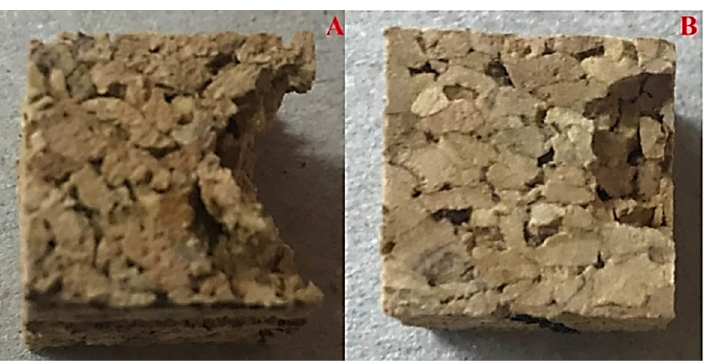
Figure 5. Brittle detachment of cork plugs after performing a dynamic compression at − 40 °C on 140 kg/m 3 ( A ) and 200 kg/m 3 ( B ) agglomerated corks (Reprinted with permission from [48]).